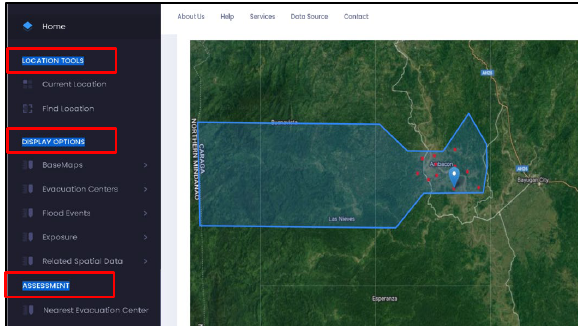
Figure 9. Main Functions in the Web Map Application